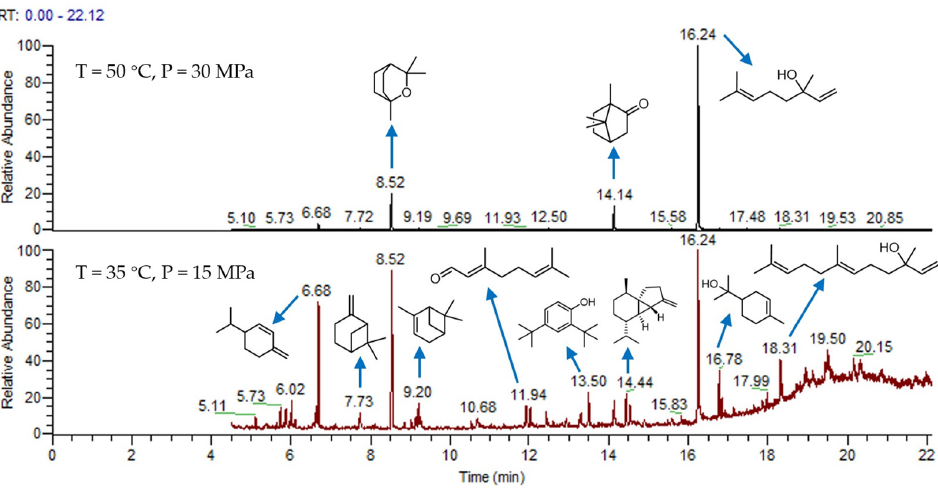
Figure 2. GC-MS of camphor tree leaves essential oil.